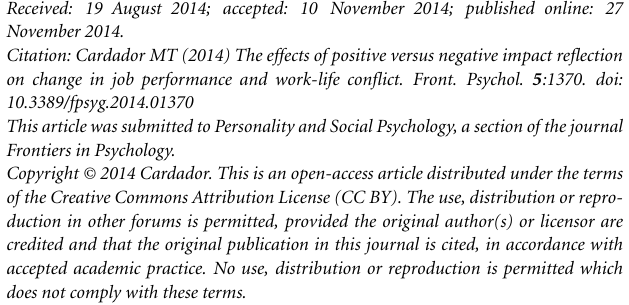
ConflictofInterestStatement: Theauthordeclaresthattheresearchwasconducted in the absence of any commercial or financial relationships that could be construed as a potential conflict of